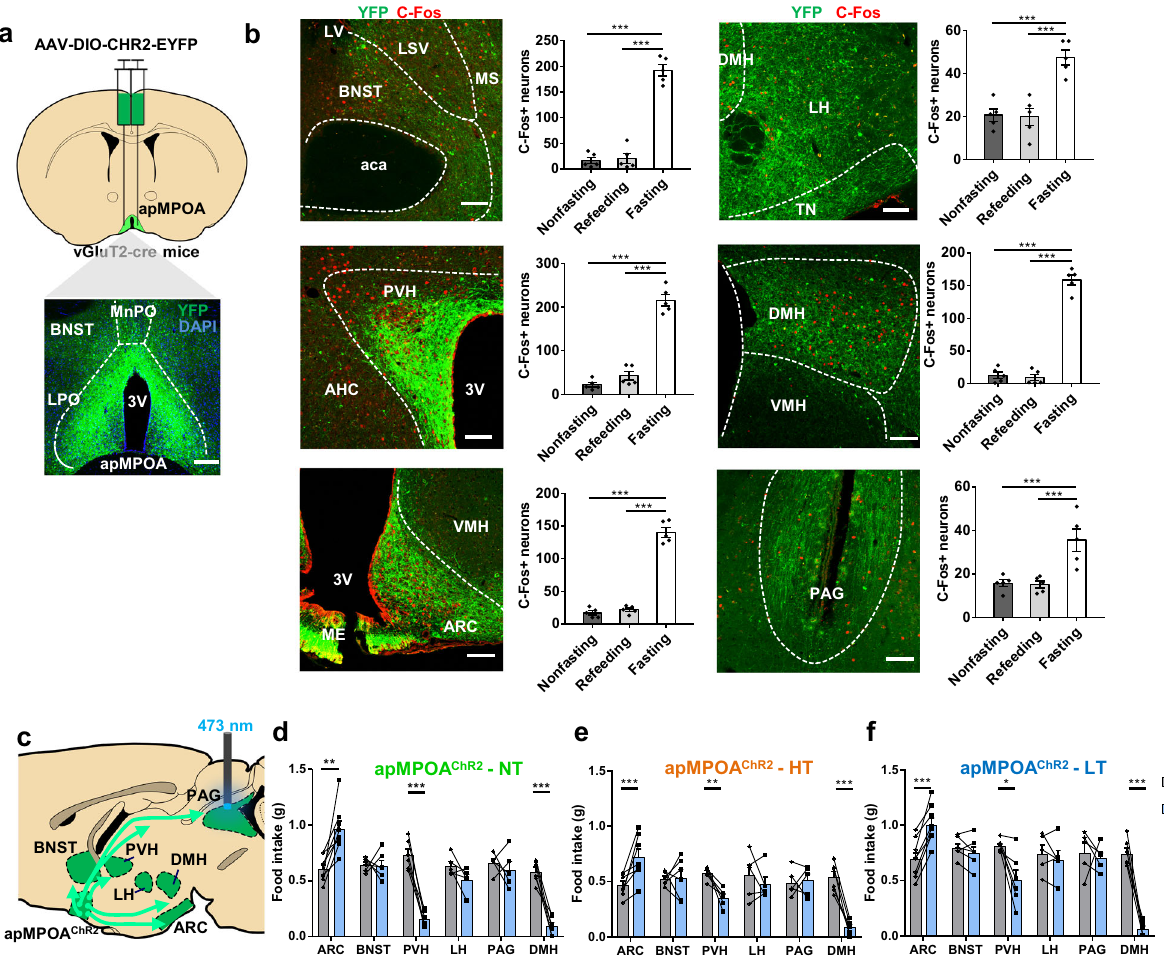
Fig. 3 Optogenetic terminal activations on the ARC and PVH orchestrate food intake. a Schematic and representative coronal images of injecting AAV virus expressing ChR2 into the apMPOA in vGluT2-cre mice. Image representative of n = 5 mice for each group of downstream targets. Scale bar, 100 µ m. b Representative images of downstream targets of glutamatergic apMPOA neurons (green, ChR2), including BNST, LH, PVH, DMH, ARC and PAG, in which fasting-induced C-Fos expression can be clearly observed compared to the re-feeding and no fasting groups (red, C-Fos). Scale bar, 100 µ m.